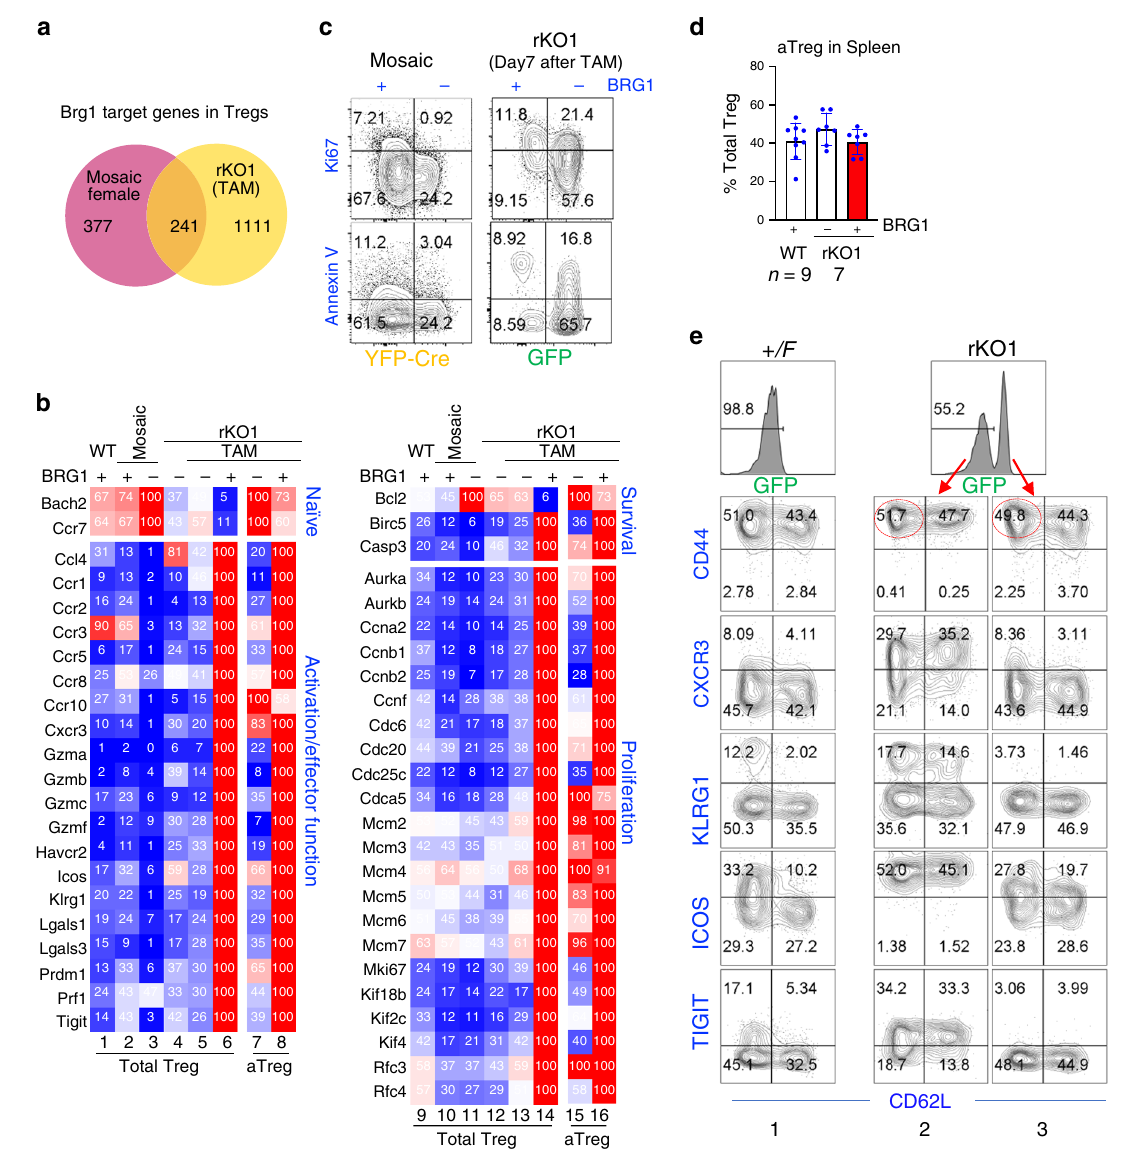
Fig. 3 Brg1 reexpression causes hyperactivation of both rTregs and aTregs. a Brg1-target genes from mosaic females and from rKO1 mice on Day 7 after TAM. The target genes were de fi ned as those whose expression was affected ≥ 2× fold by BRG1. b Relative expression of representative Brg1 target genes associated with Treg function (lanes 1 – 8) or turnover (lanes 9 – 16). Total Tregs (1 – 6, 9 – 14) and aTregs (7 – 8, 15 – 16) were isolated and sequenced in two different experiments, and therefore relative expression calculated independently. c FACS analysis of proliferation and apoptosis in the Tregs from mosaic females (left) and from the rKO1 mice on Day 7 after TAM (right). The two mice were analyzed at different times. d , e FACS analysis of aTreg proportion ( d ) and Treg activation marker expression ( e ), showing that in rKO1 mice on Day 7 after TAM, Brg1 reinstated aTreg and rTreg, both expressed activation markers more frequently and, for CXCR3 and ICOS, to higher levels than normal aTregs. The circles in e denote the aTregs used for RNA seq in b , samples 7 – 8 and 15 –